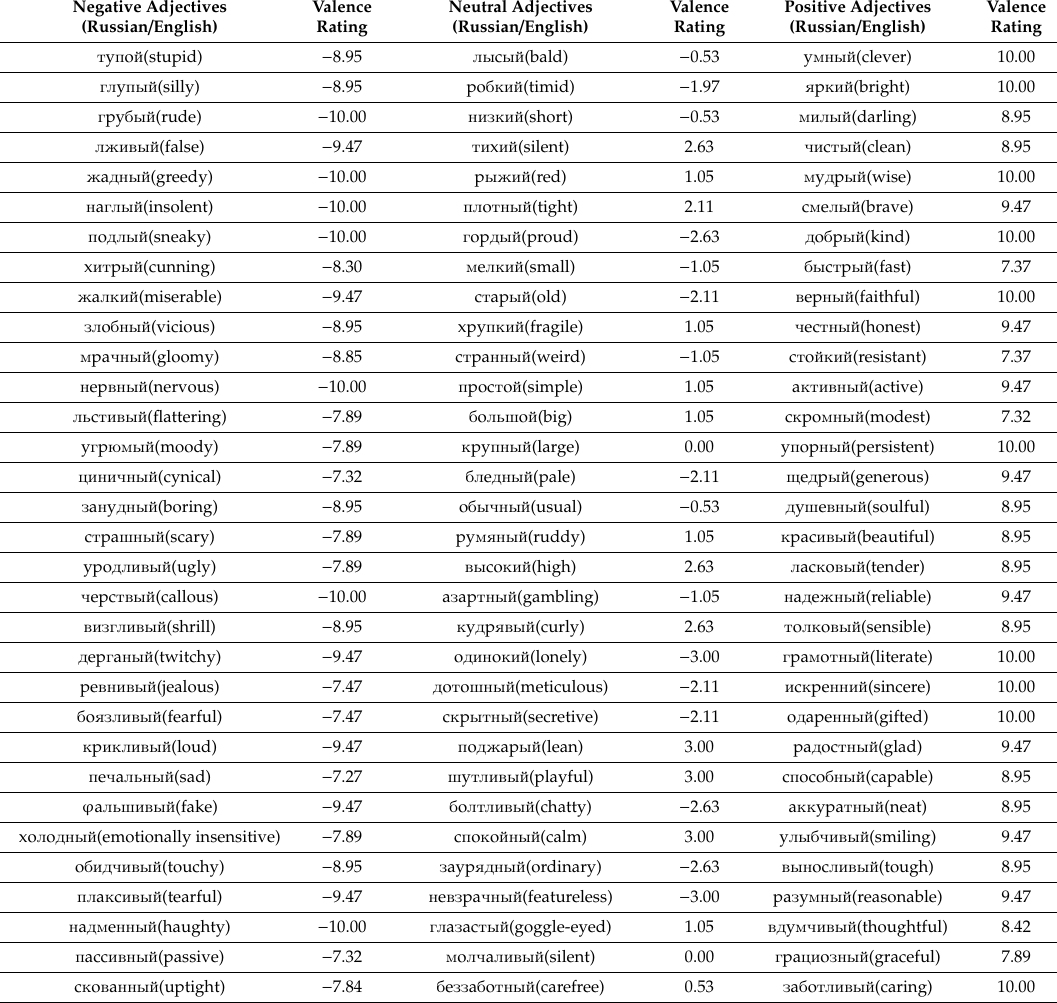
Table 1. Verbal stimuli from the di ff erent categories with the valence ratings in a preparatory behavioral